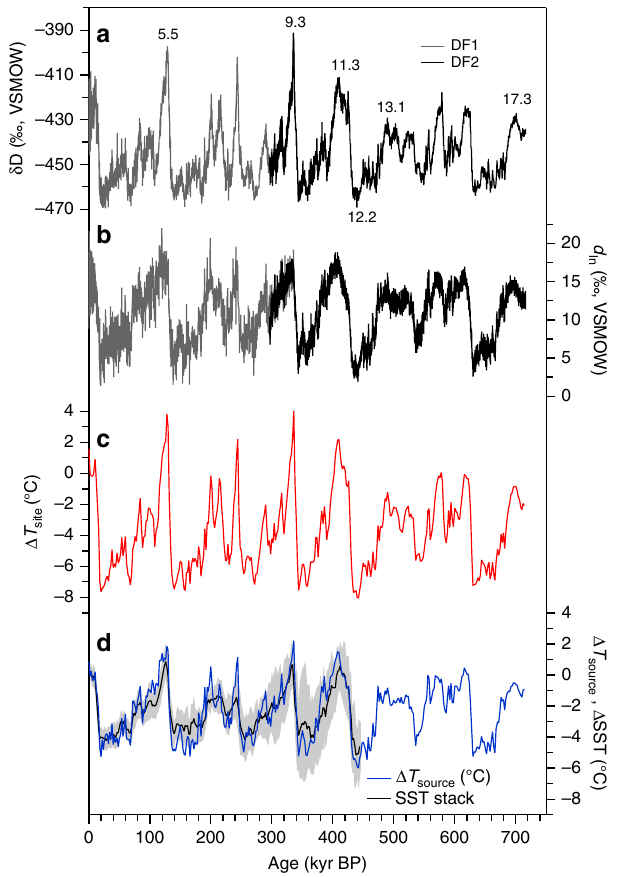
Fig. 2 Isotope records from the DF1 and DF2 ice cores. Isotope records from DF1 (grey) and DF2 (black) for a δ D and b d ln , as well as records of c Δ T site (red) and d Δ T source (blue) for DF. The black line indicates the stacked SST record within the moisture source region for precipitation (grey shading represents the range of variability) (Supplementary Fig. 4). Temperatures are shown as deviations from the modern value (i.e. the average of the past 2 kyr). The Δ T site and Δ T source records were resampled at a 2-kyr interval for clarity. Numbers indicate Marine Isotope